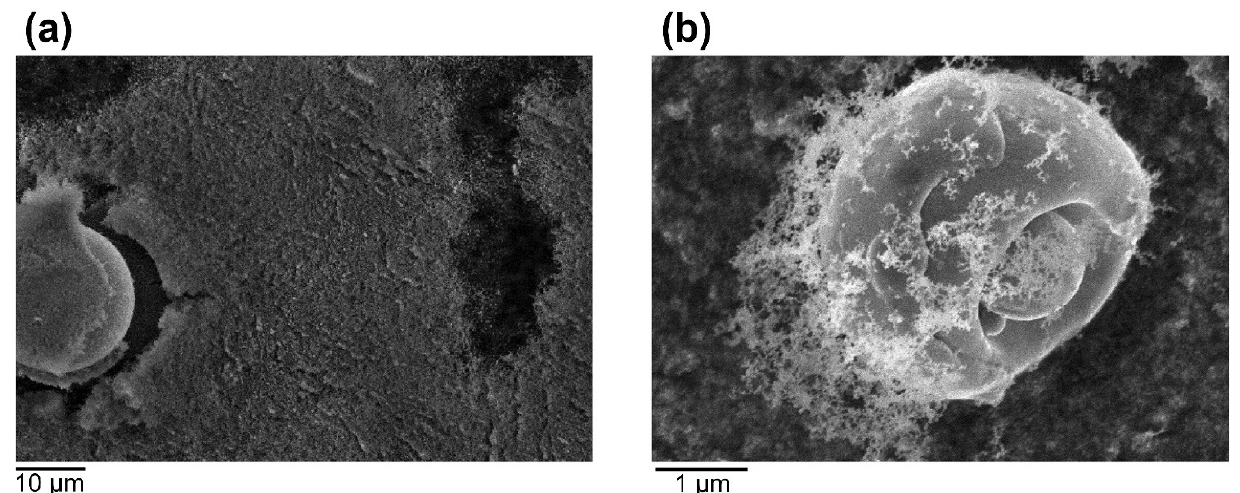
Figure 21. SEM images of condensate. ( a ) A heavy concentration of condensate. ( b ) Condensate on a captured laser spatter particle. (Reprinted with permission from Ref. [90]. Copyright 2019 Elsevier B.V.).